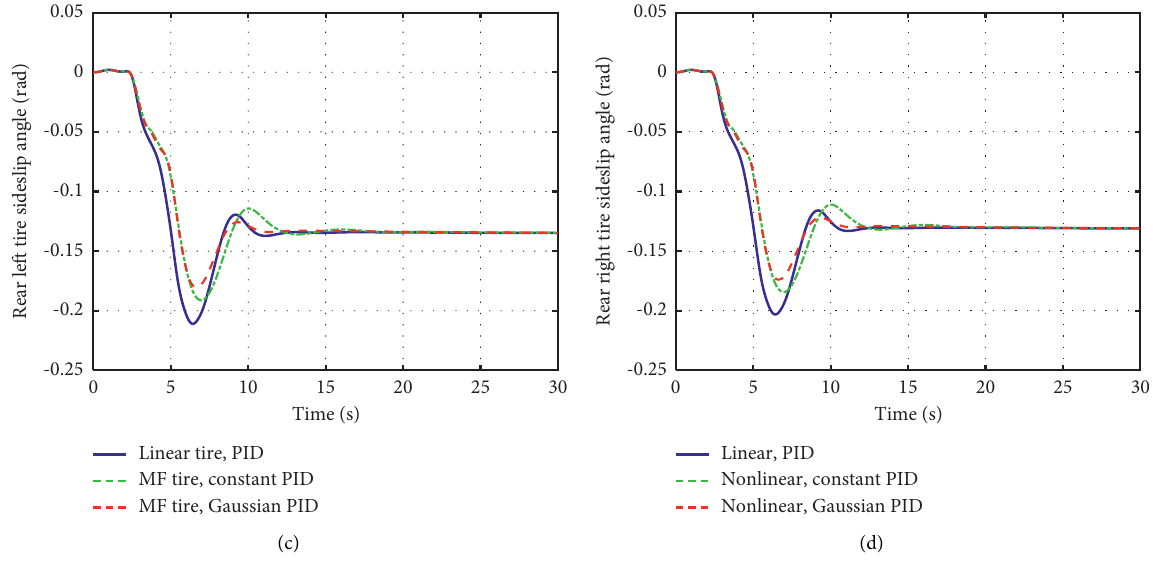
Figure 17: Comparison of tire sideslip angle. (a) Front left tire. (b) Front right tire. (c) Rear left tire. (d) Rear right